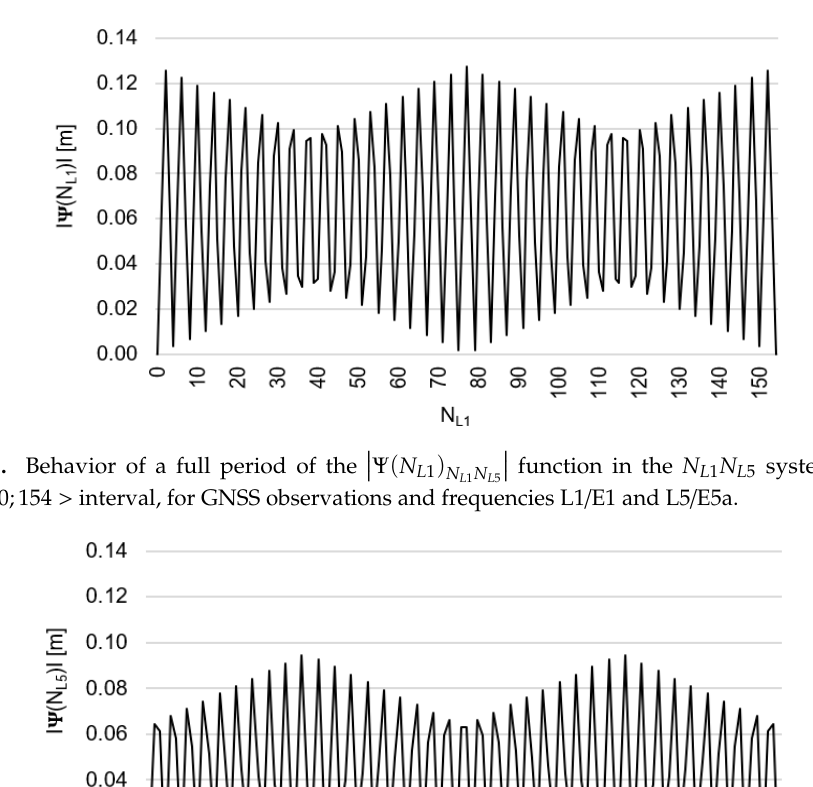
(cid:3627) in the 𝑁 (cid:3013)(cid:2873) 𝑁 (cid:3013)(cid:2869) system, in the 𝑁 (cid:3013)(cid:2873) ∈< (cid:3261)(cid:3121) (cid:3015) (cid:3261)(cid:3117)